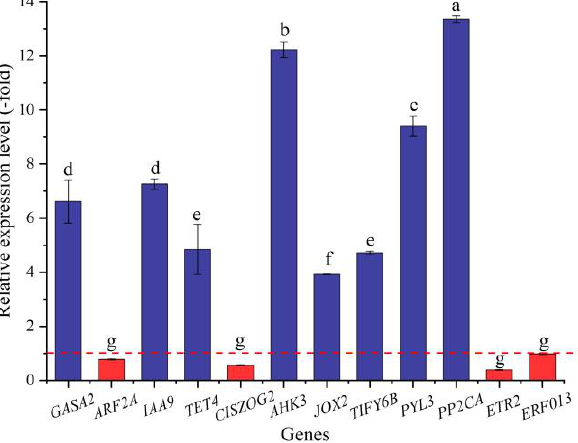
Figure 11. The RELs of genes directly associated with hormone response in A. venetum seeds at 300 mmol/L NaCl vs. CK (mean ± SD, n = 3). Different letters represent a significant difference ( p < 0.05) among different genes. The red dotted line differentiates UR (>1) and DR (<1).